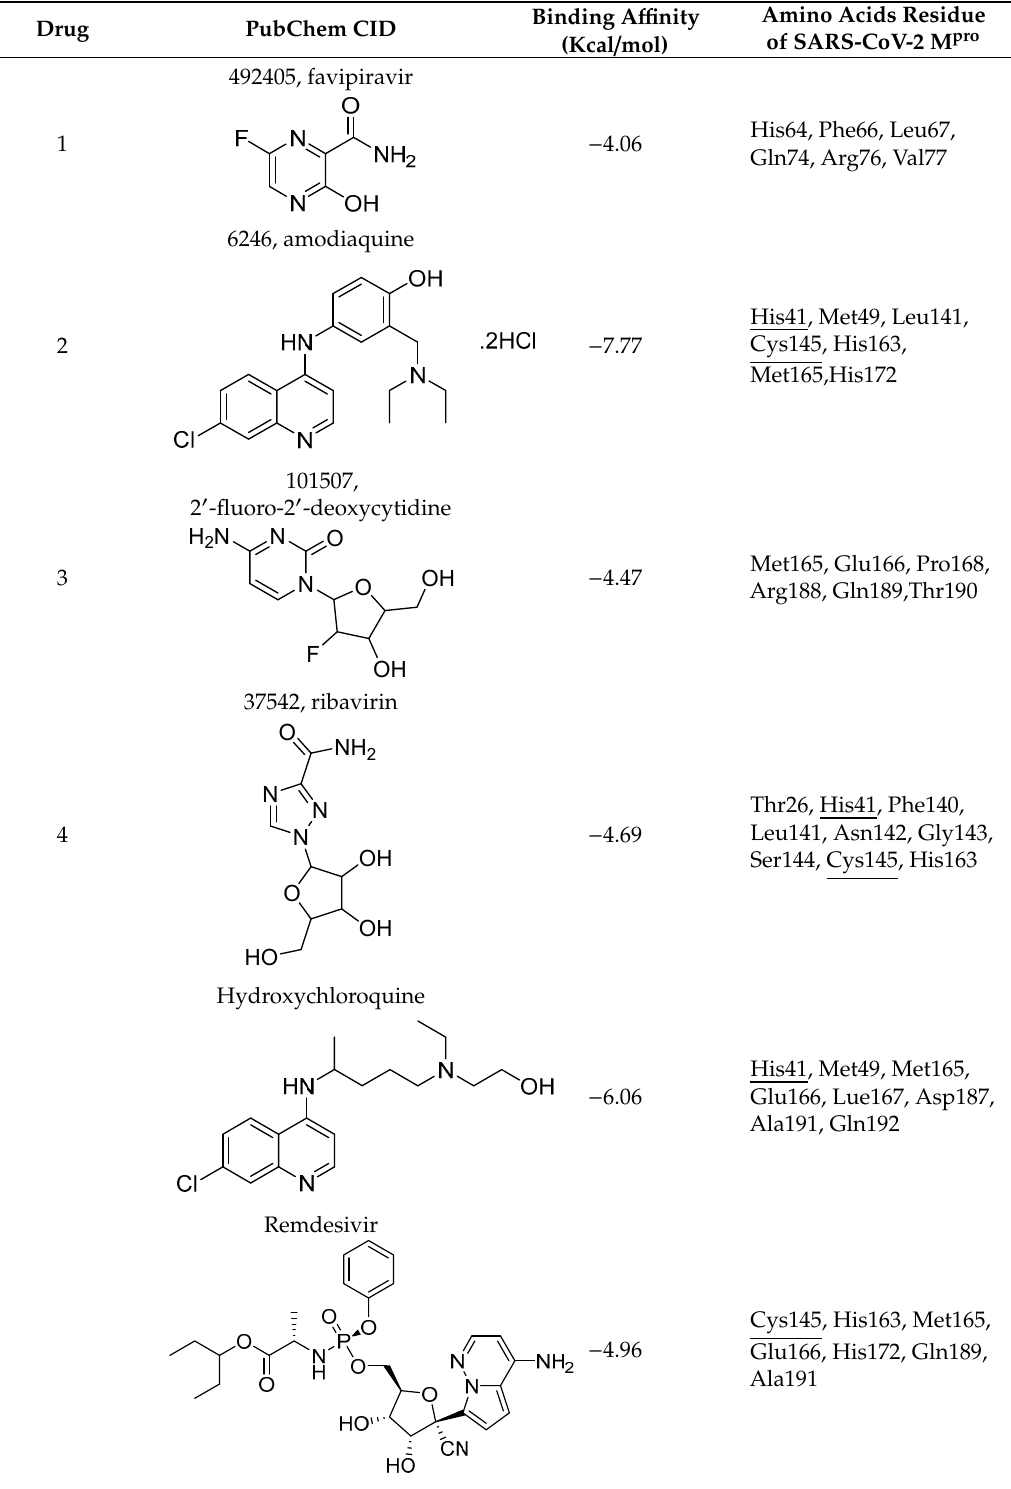
Table 4. Data analysis of the flexible docking of drugs 1–4, hydroxychloroquine and remdesivir in the active site of SARS-CoV-2 M pro receptor.